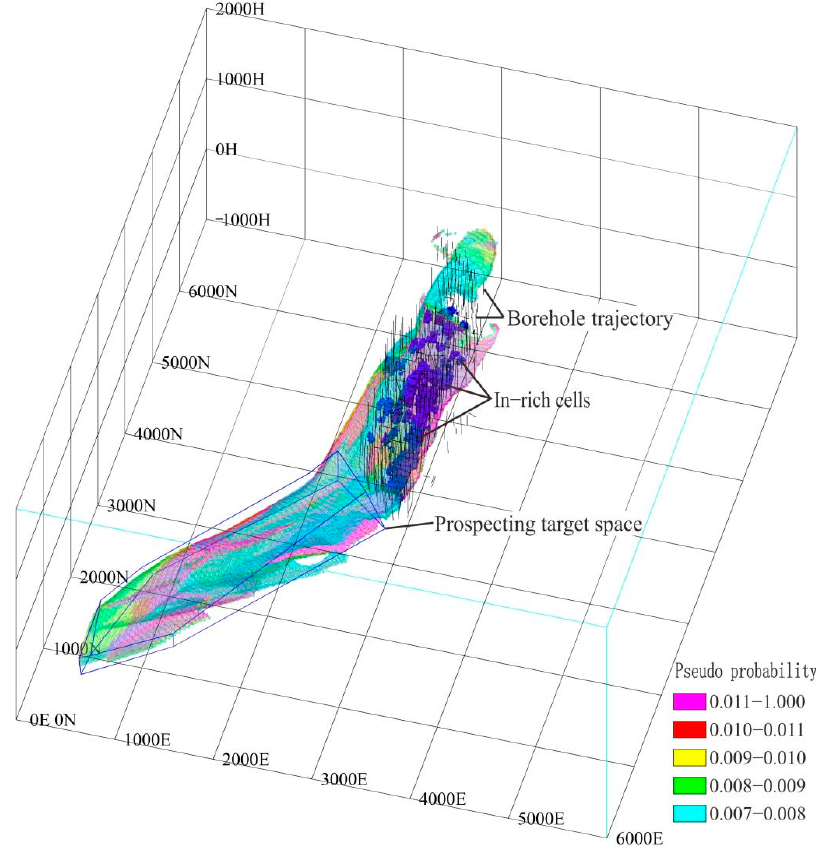
Figure 7. Metallogenic prediction map of artificial neural network method (prediction probability of indium-rich cell > 0.007).